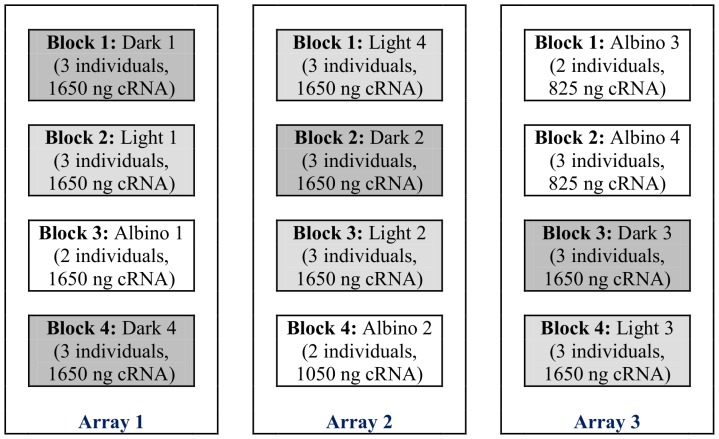
Hybridisation layout of the albino, light and dark groups across three 4×44K microarrays.